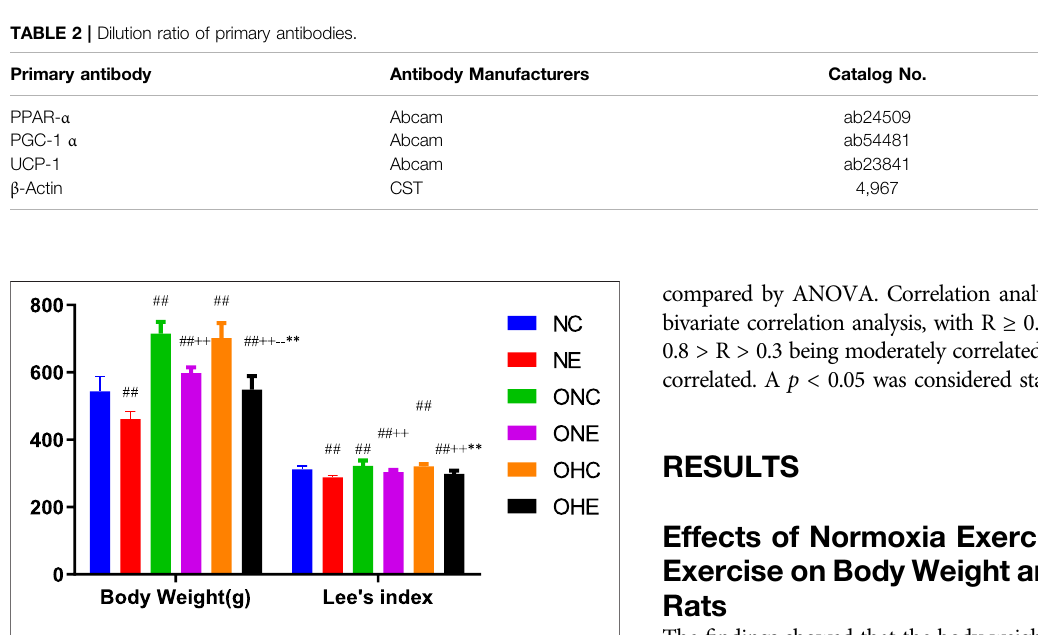
FIGURE 1 | Changes in Body Weight and Lee ’ s Index of Rats after NormoxicandHypoxicExercise. n =8, # p < 0.05vs.NCgroup;## p < 0.01vs. NC group; + p < 0.05 vs. ONC group; ++ p < 0.01 vs. ONC group; - p < 0.05 vs. ONE group; -- p < 0.01 vs. ONE group; * p < 0.05 vs. OHC group; ** p < 0.01 vs. OHC group; following tables